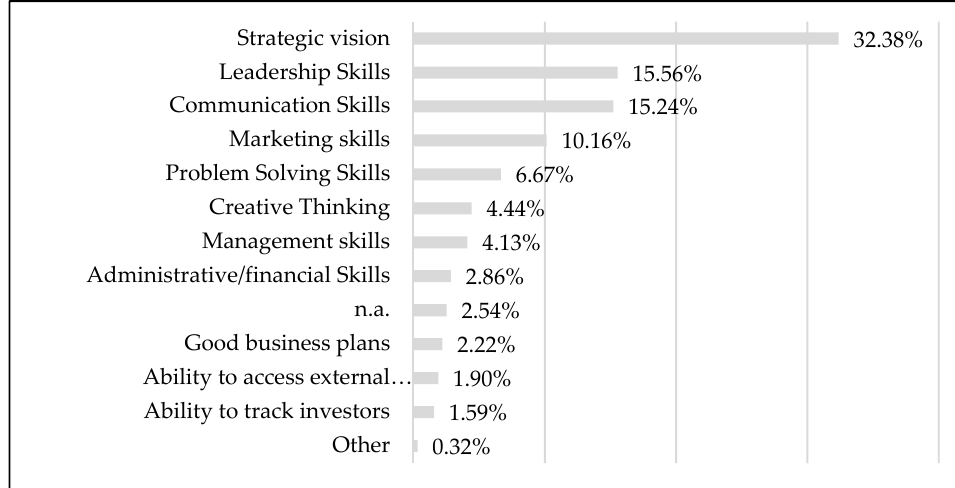
Figure 4. Managerial factors that support the growth of CCIs. Ranking results Source: Authors elaboration on data collected and shown in TRACES D3.1 deliverable.